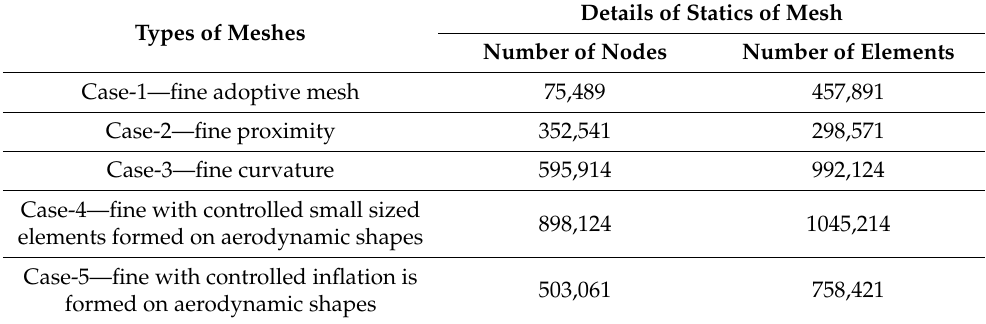
Table 13. Comparative information of all the mesh cases.